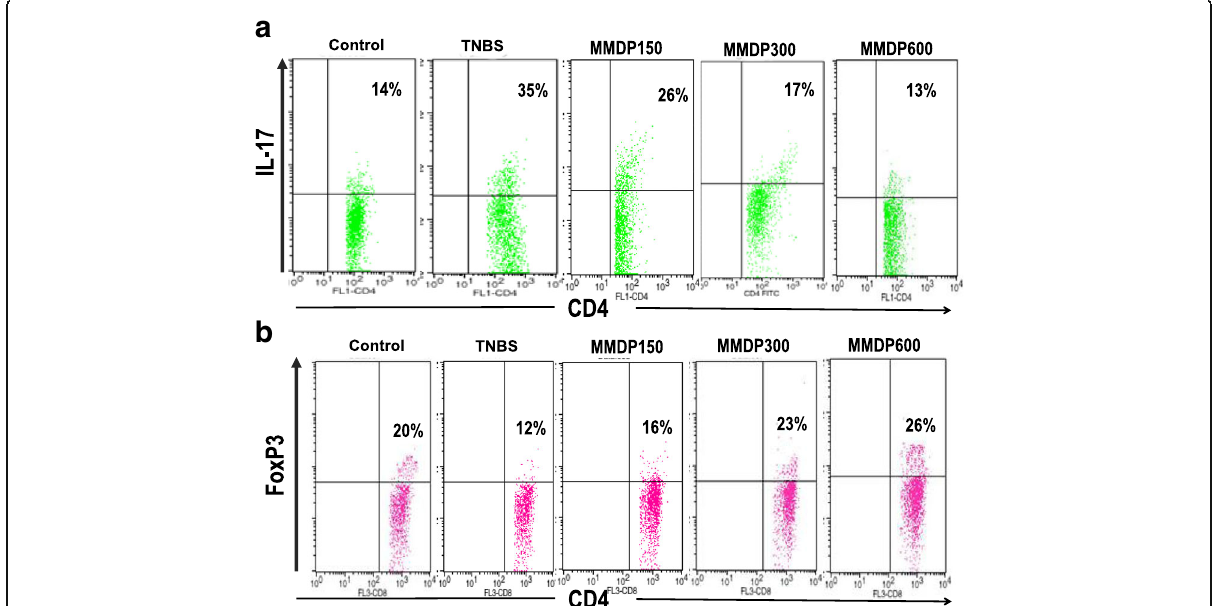
Fig. 5 Effect of mango mistletoe Dendrophthoe pentandra (MMDP) extract on Foxp3 protein in CD4 + CD25 + T cells and Th17 cells. The effect of MMDP extract on the regulatory T cell (Treg) population and Th17 cells in mice with trinitrobenzene sulfonic acid (TNBS)-induced colitis is shown. a . Mesenteric lymph node (MLN) cells were isolated from each group and subjected to intracellular interleukin IL-17 staining. b . The percentage of Treg (CD4 + CD25 + Foxp3 + ) and Th17 (CD4 + IL-17 + ) cells were analyzed using a FACS Calibur flow cytometer (BD Biosciences). Numbers represent the percentages of IL-17 expressing CD4 + T cells and Foxp3-expressing CD4 + CD25 + T cells in each quadrant are shown. Percentages of cells in each quadrant are shown inside the panels. Representative results of six mice in each group are